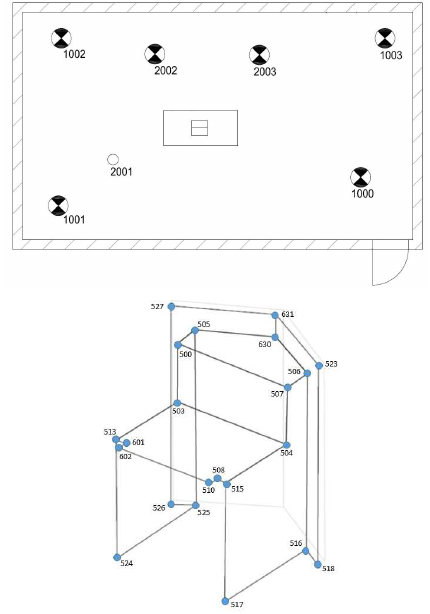
Figure 6: Sample indoor scenario for the photogrammetric recon- struction of a small object using known control points (top: scene plan; bottom: reconstruction). K¨ohler,